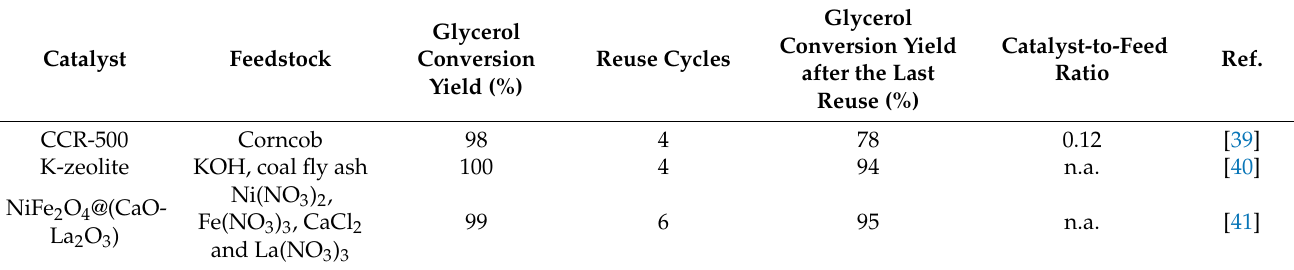
Table 1. Comparison of CCR-500 catalyst with two reported catalysts representing low and high